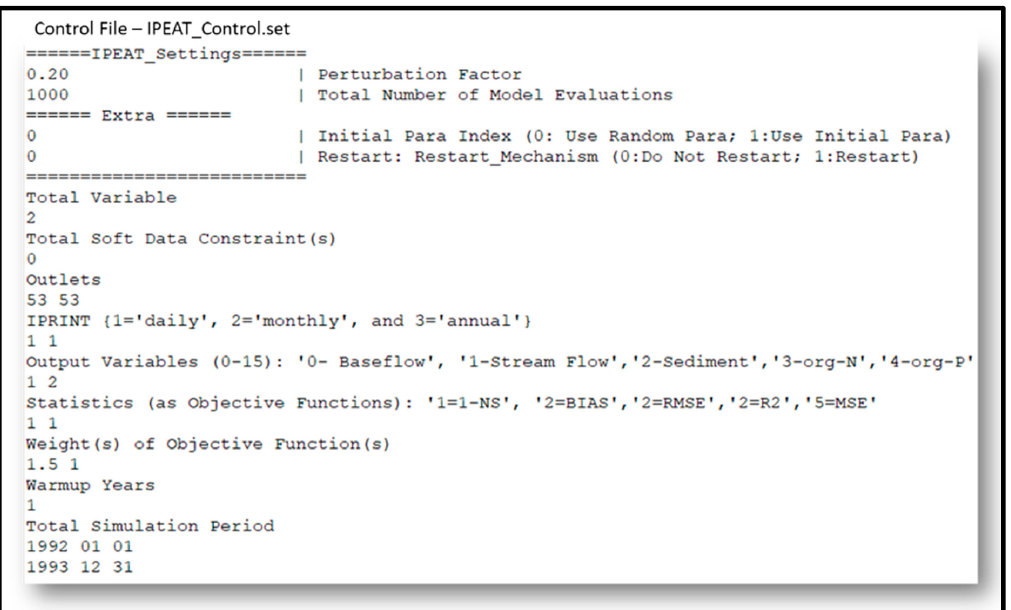
Figure 2. Illustration of IPEAT+ input files: IPEAT_Control.set with required settings .